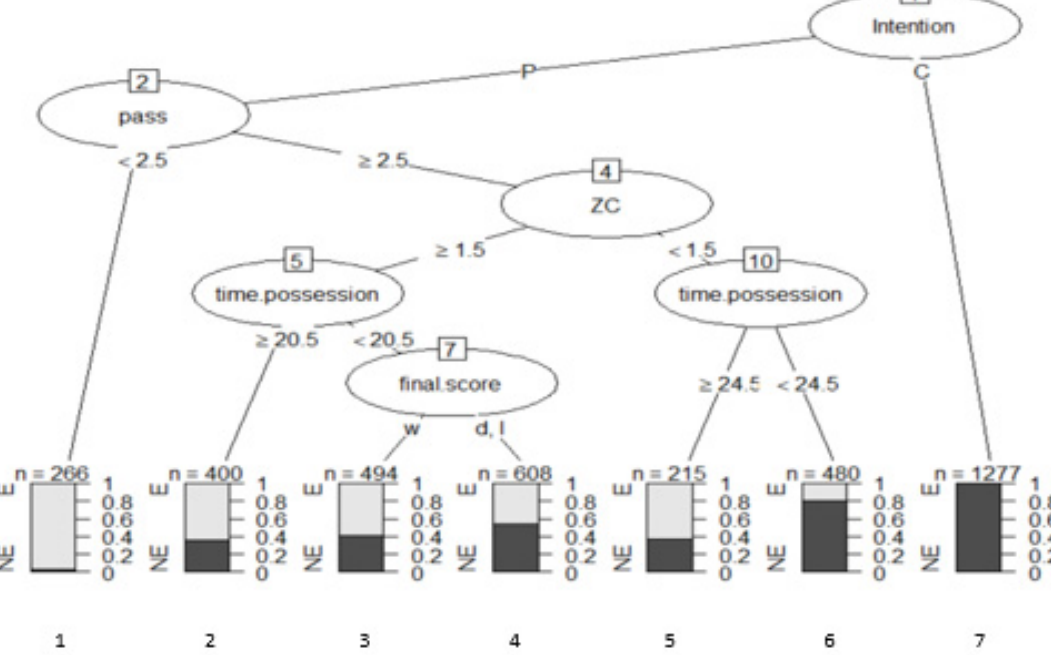
Figure 1. Graphic representation of the model.